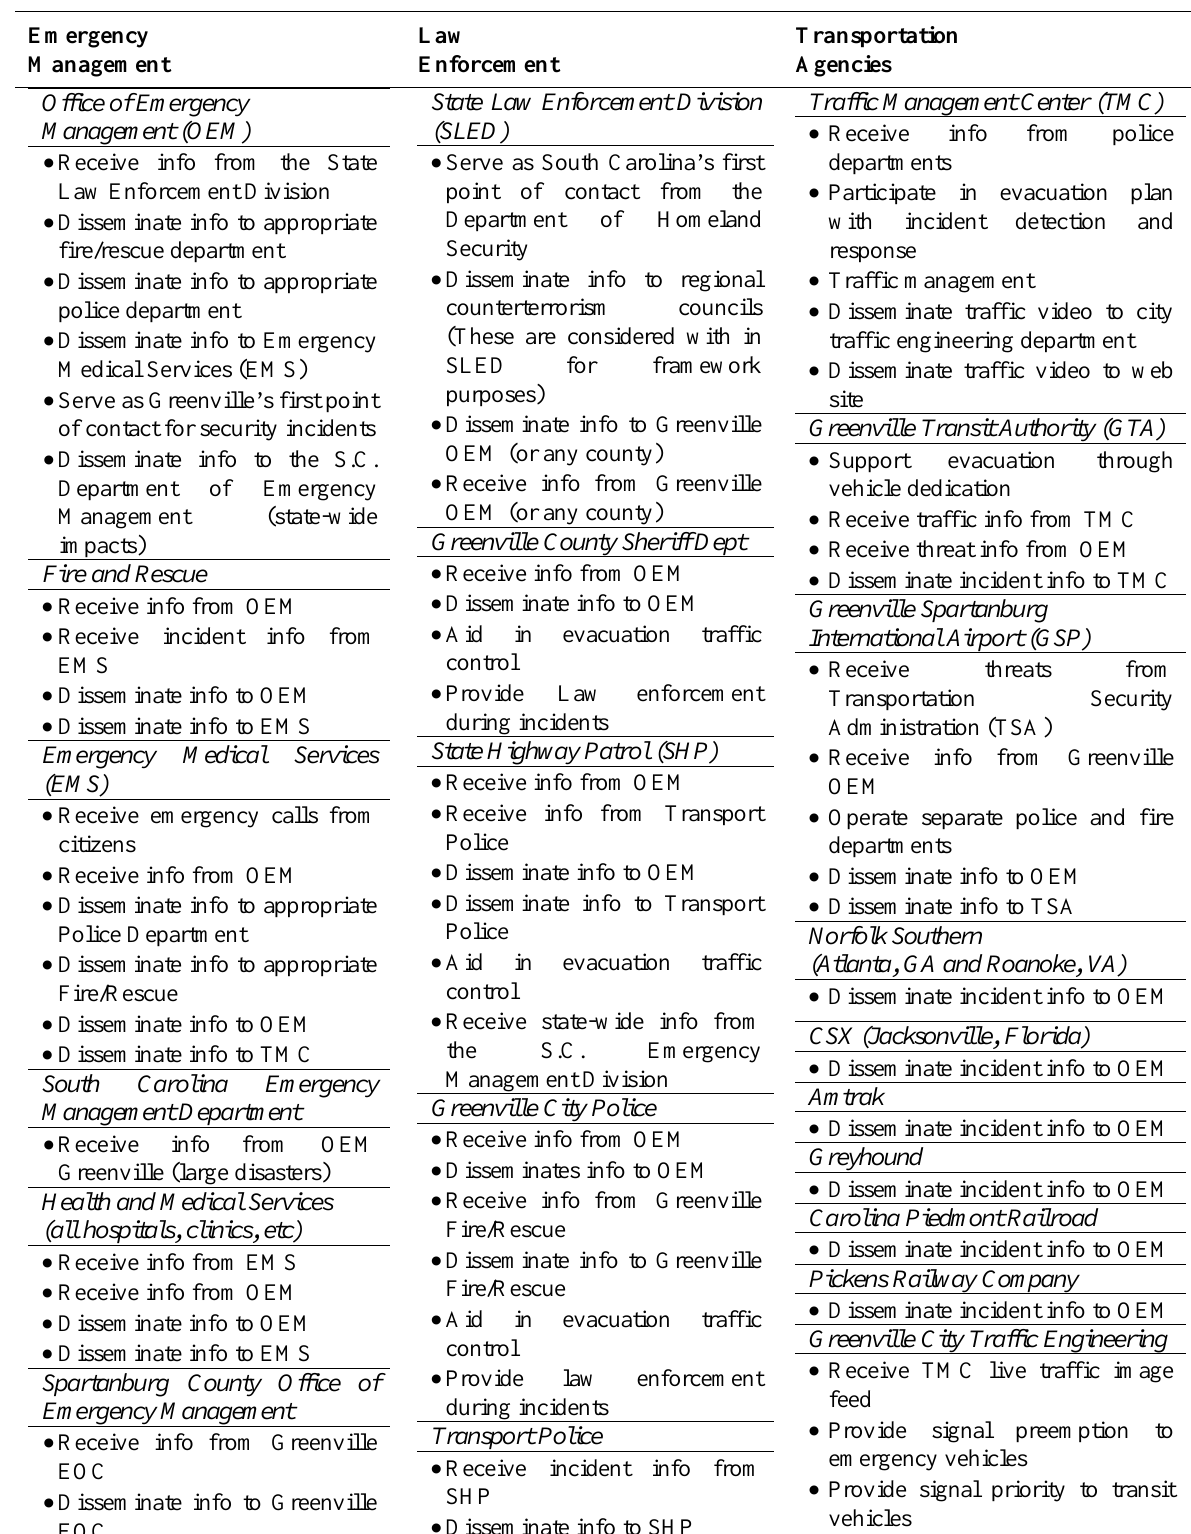
Table 2. Public Agencies and Responsibilities for Transportation Emergency Response in Greenville, South